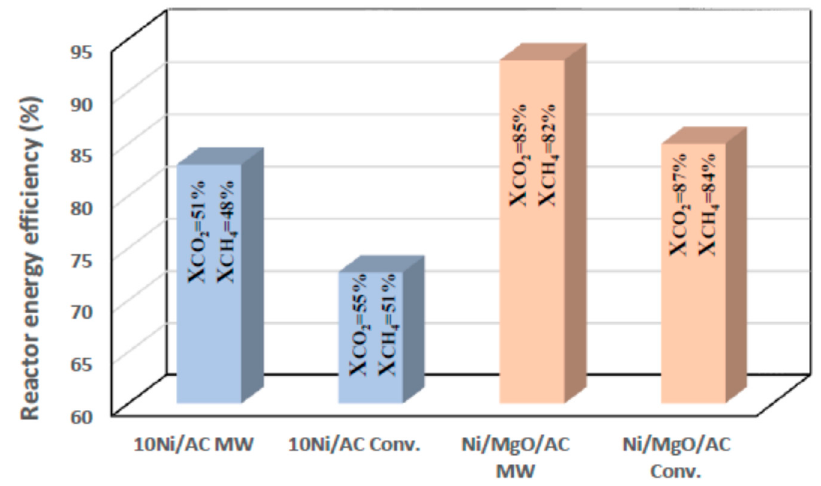
Figure 6. Energy efficiencies of microwave and conventional heating reactors using Ni/AC and Ni/MgO/AC